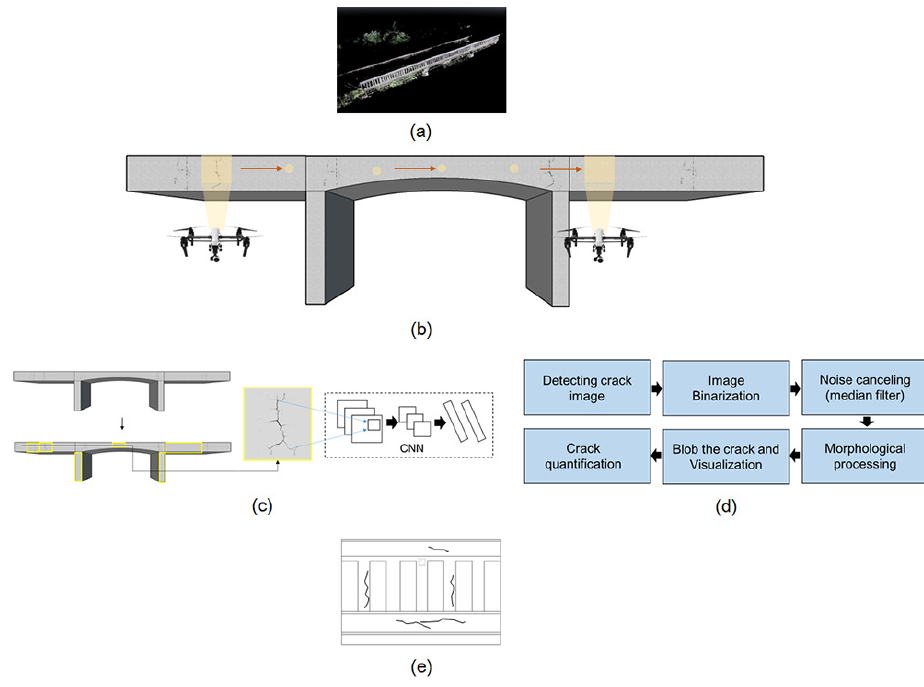
Figure 1. Overview of the UAV-based crack identification: ( a ) Generating background model; ( b ) Image acquisition to scan appearance status; ( c ) Crack detection using deep learning algorithm; ( d ) Crack quantification using image processing and ( e ) Visualization of identified crack on the inspection